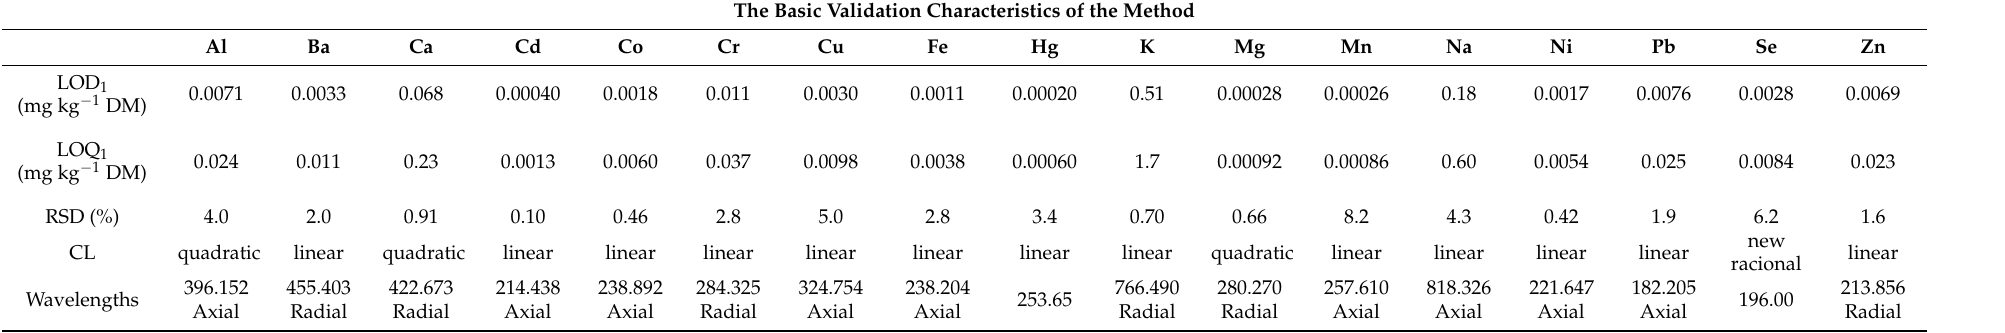
Table 2. The basic validation characteristics of the